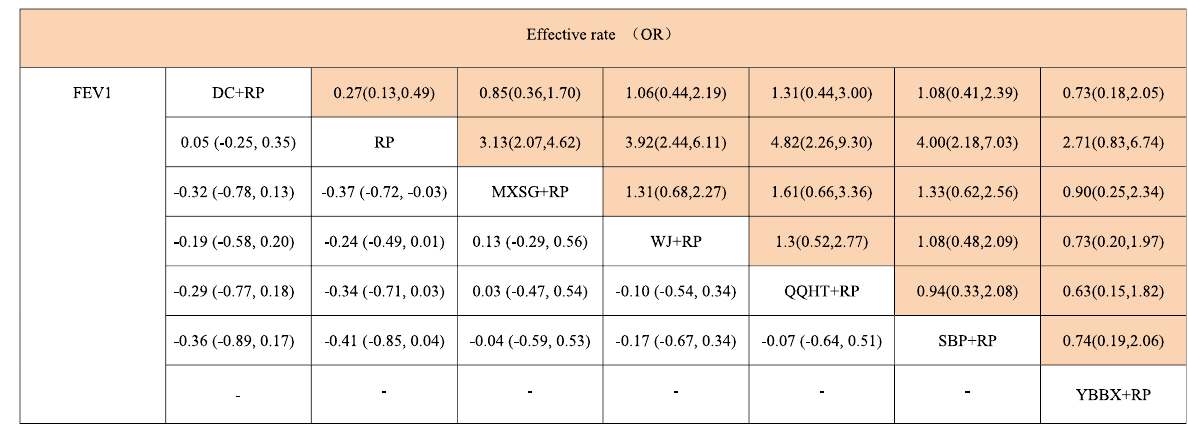
Table 3 Network meta-analysis of FEV1 and Effective